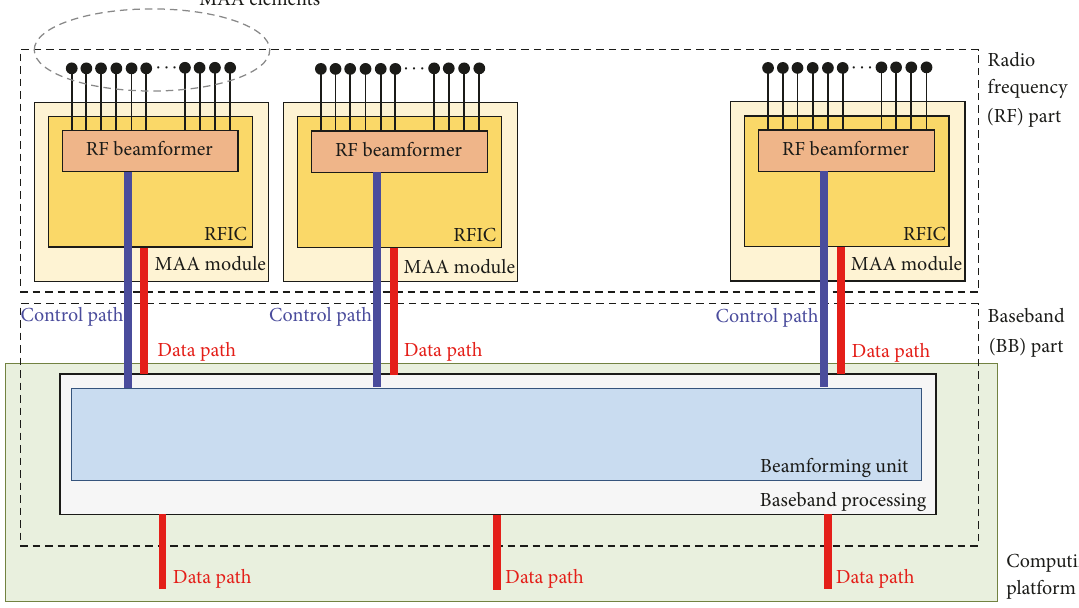
Figure 1: High level block diagram of the proposed modular antenna array (MAA)